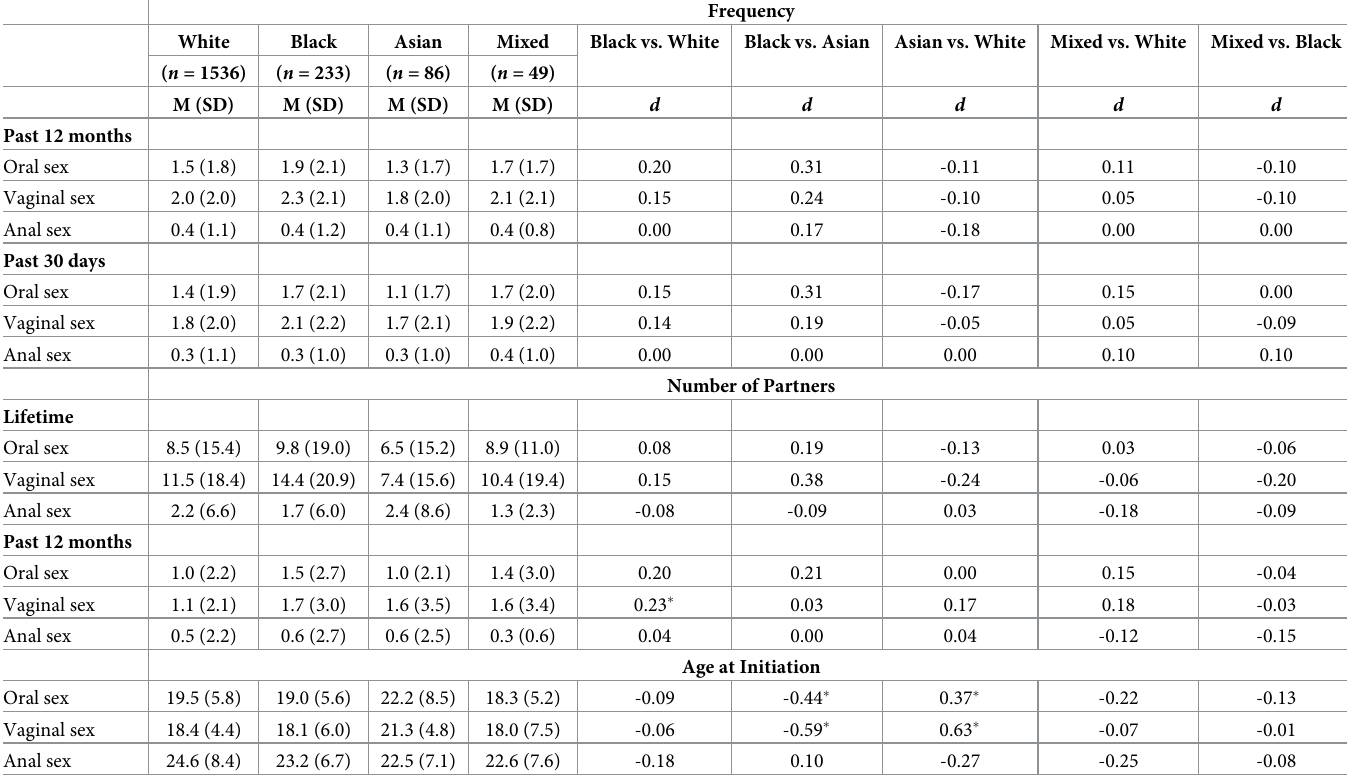
Table 8. Descriptive statistics and standardized effect sizes for group comparisons for racial